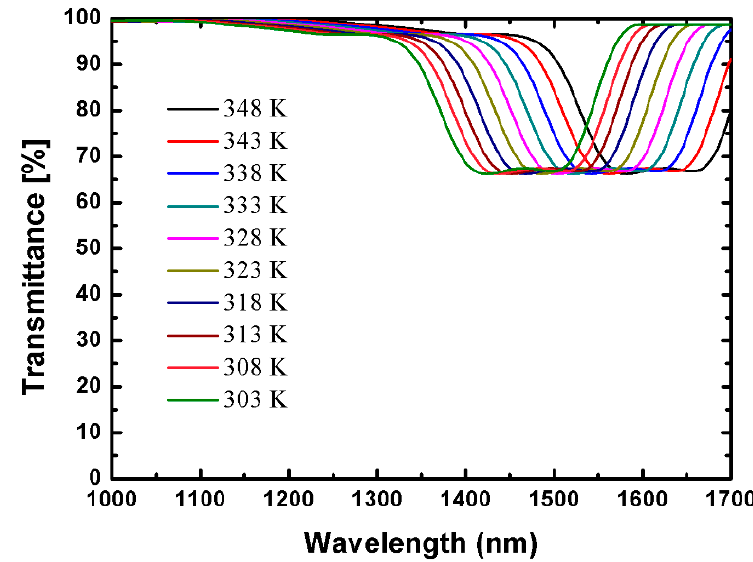
Figure 5. Transmission spectra of the PSCLC filter with a holding treatment in thermal modulation.